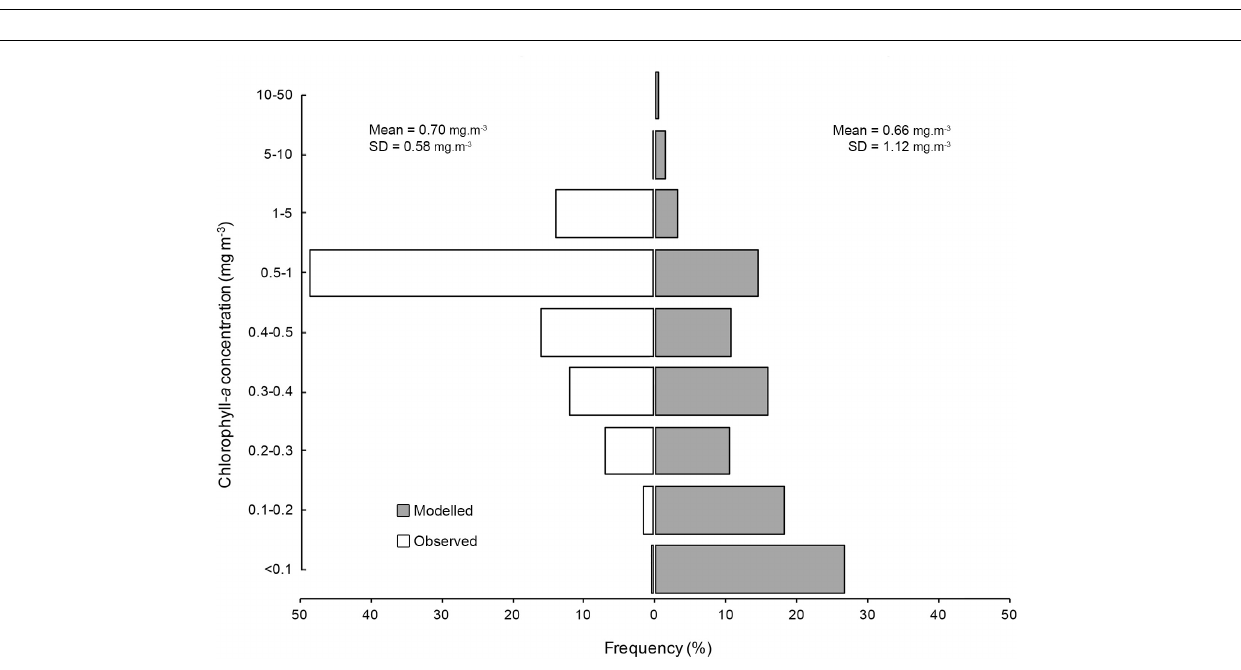
FIGURE 8 | Sea surface temperature preferences for satellite tracked M. alfredi (white) and modelled tracks (grey).